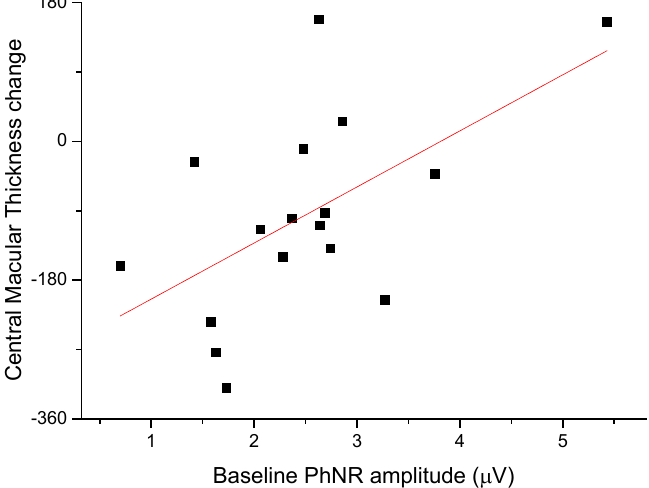
Figure 5. At the end of follow-up, the change in CMT was positively correlated with baseline PhNR amplitude (r = 0.58, p < 0.01).